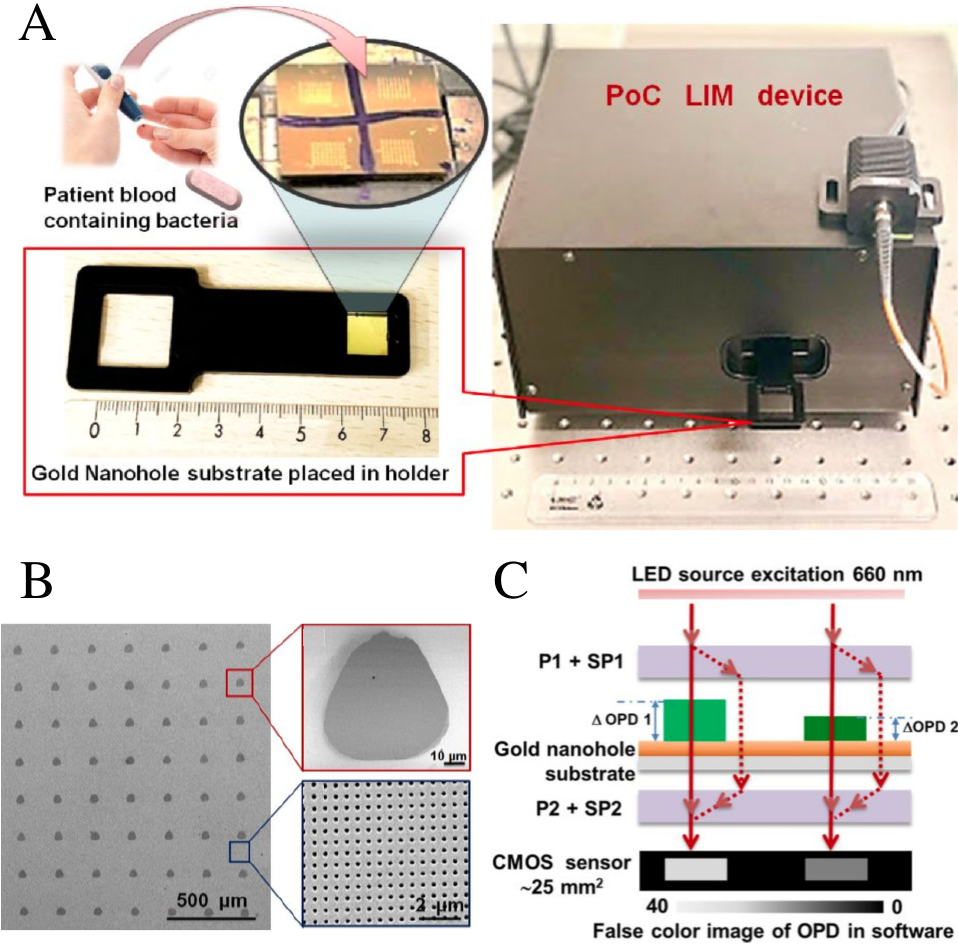
Figure 3. ( A ) Overview of the blood sampling and incubation onto the microarray biofunctionalized nanoplasmonic substrate for further analysis into the PoC LIM device. ( B ) SEM image of the 8 × 8 two-dimensional periodic bioprinted microarrays of protein G. The period length is 250 µ m, as can be noted from the scale bar = 500 µ m. The right upper-side and left lower-side insets show a zoomed view of a microspot with dimensions ≈ 50 × 55 µ m 2 and the underlying gold nanohole array with 200 nm diameter and 600 nm for the period length. The plasmonic interferometric working principle is illustrated in ( C ). Reproduced with permission from Ref. [65]. Copyright 2019 American Chemical